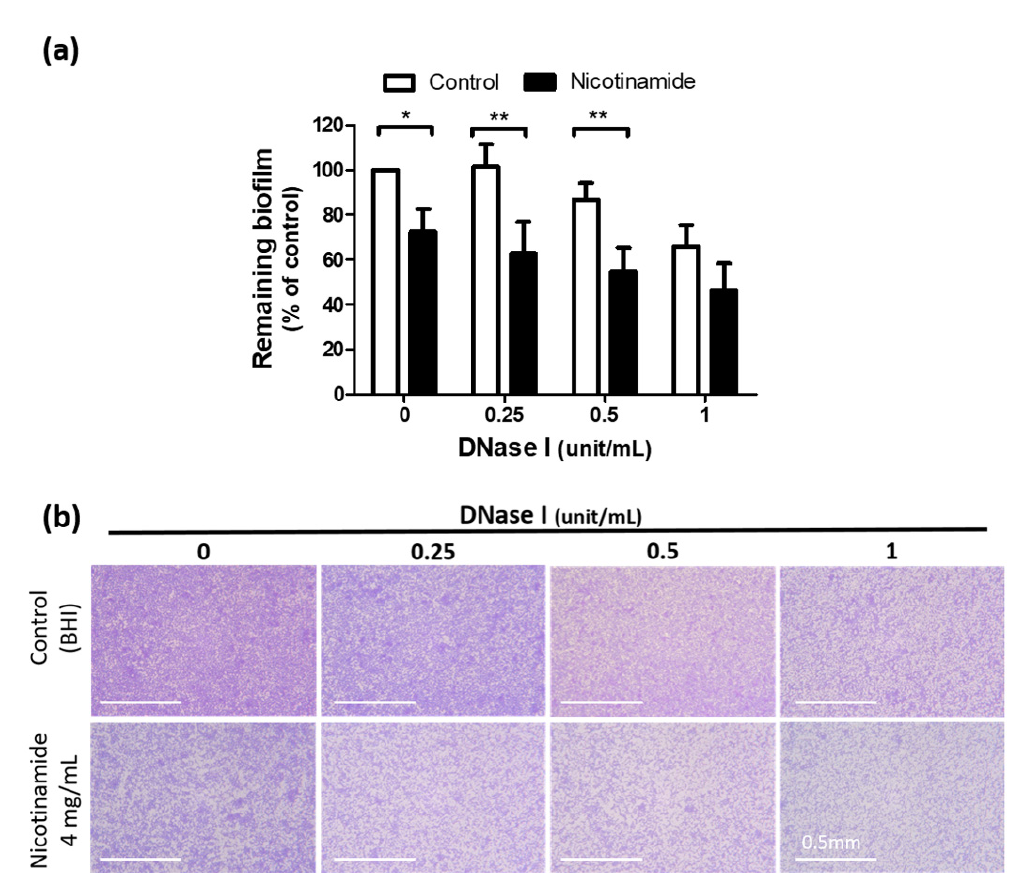
Figure 5. Nicotinamide (NAM) enhances the antibiofilm effect of deoxyribonuclease (DNase) I against Cutibacterium ( C .) acnes . ( a ) The biofilm of C. acnes was treated with DNase I at the indicated concentrations in combination with NAM or the control. n = 5 (mean ± SEM, * p < 0.05, ** p < 0.01). ( b ) Representative images showing the effect of DNase I against the biofilm of C. acnes with or without NAM. Original magnification, 100 × . Scale bar = 0.5 mm. BHI, brain heart infusion.